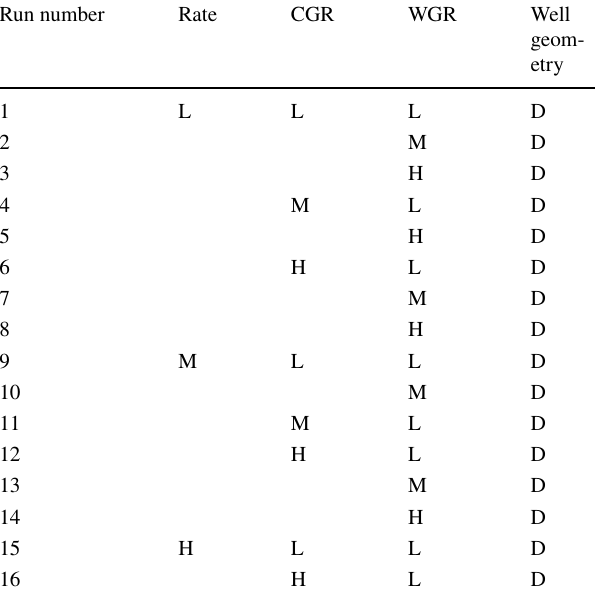
Table 5 Classification of different model runs for deviated